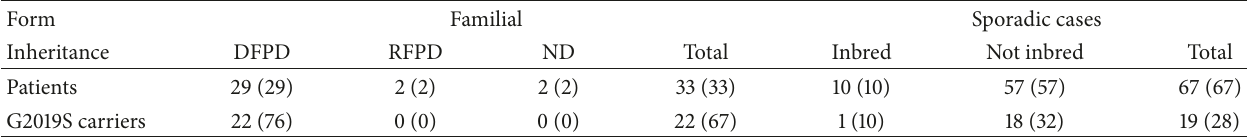
Table 2: Prevalence of G2019S mutations among 100 Moroccan PD